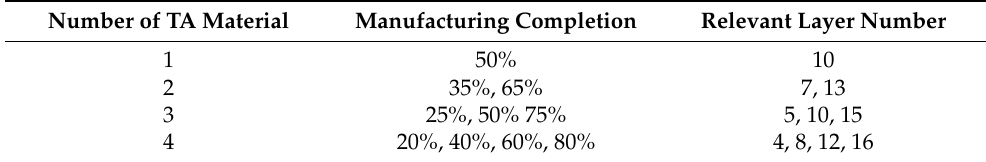
Table 2. Configuration of tensile testing samples.